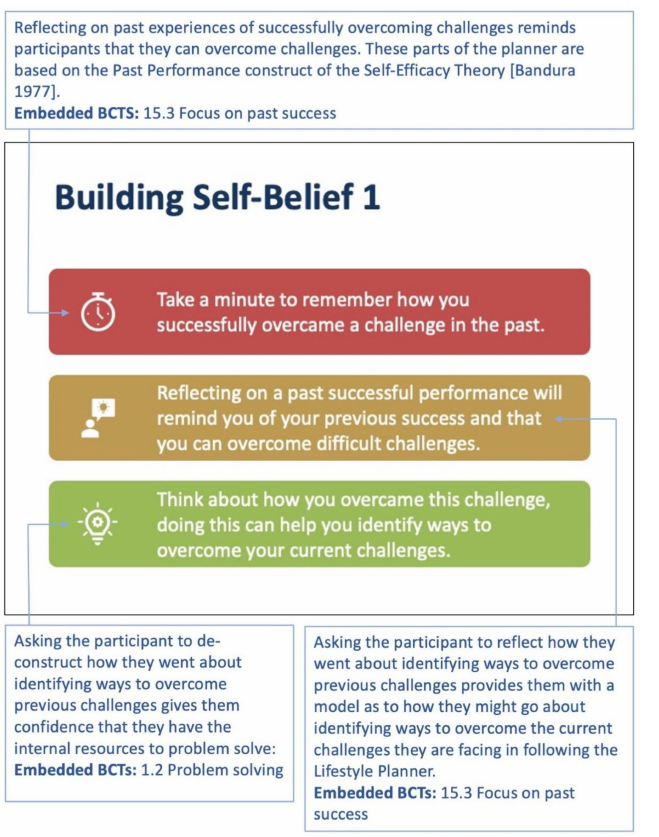
Figure 13. Week 1: On weeks 1, 5 and 9, participants are asked to reflect on past success through a self-reflection process. The text in the blue boxes is explanatory text and not part of the planner. The BCTs used, refer to the Michie et al. taxonomy [17].